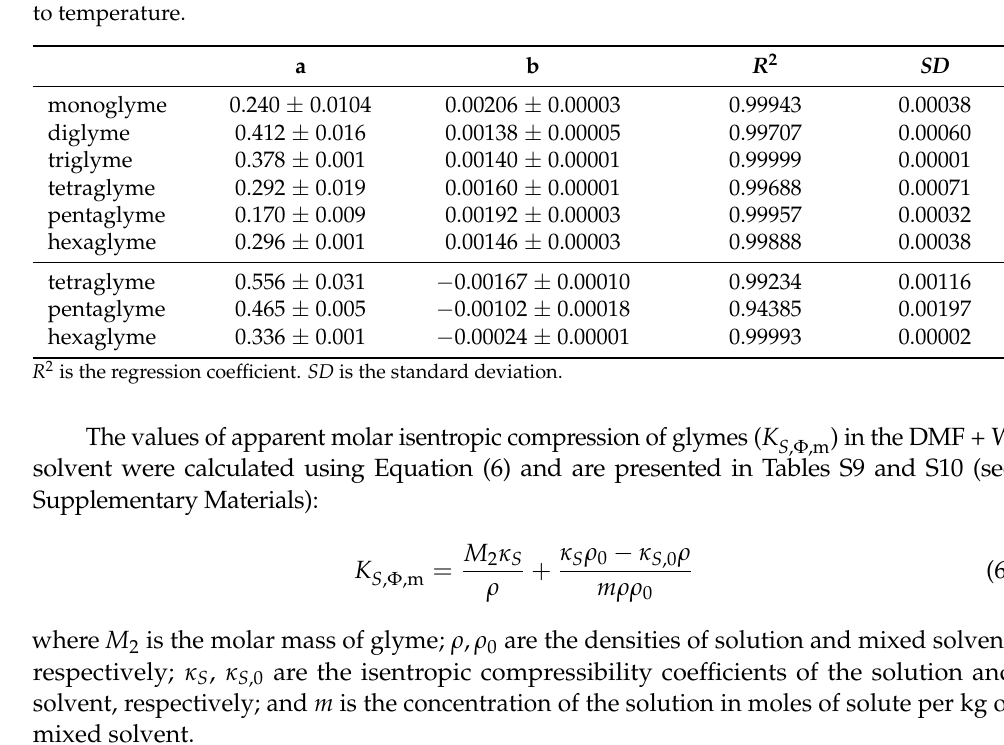
= + ⋅ that describe the depend-